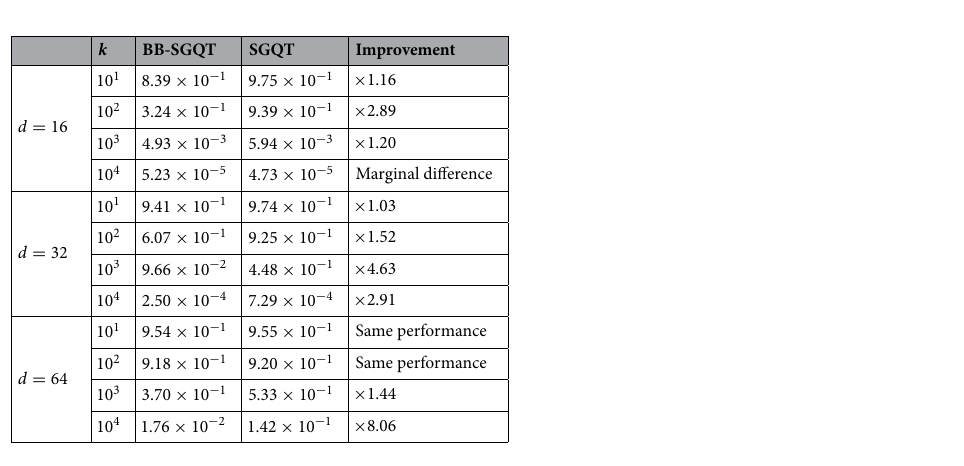
Table 1. Scaling of performance in BB-SGQT vs SGQT with qubit